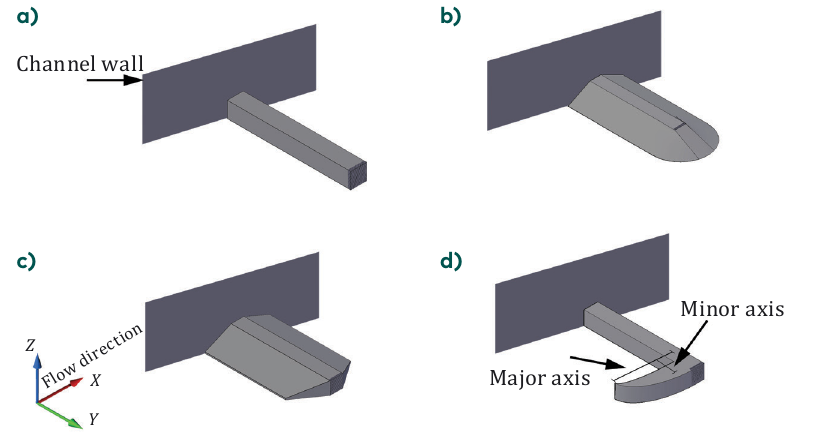
Figure 2. 3D views of basic embankment shapes: a) vertical-wall; b) spill-through; c) wing-wall; d) elliptical guide